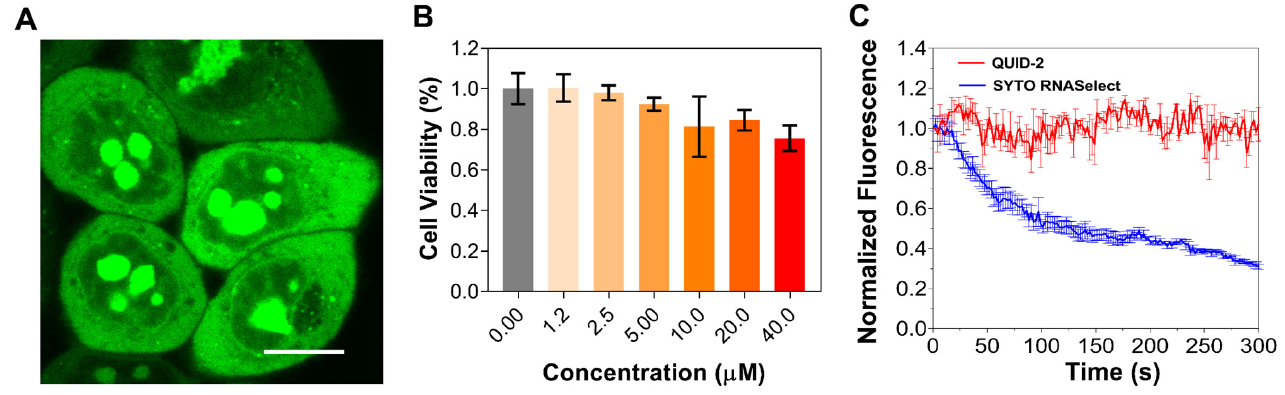
Figure 5. ( A ) Imaging of live HeLa cells stained with QUID − 2 (0.5 µ M, λ ex = 488 nm, λ em = 500–600 nm, green). ( B ) Viability of HeLa cells exposed to different concentrations of QUID − 2 for 48 h determined by MTT assay. ( C ) Quantitative analysis of the changes in fluorescence intensities of QUID − 2 and SYTO RNASelect in live cells under continuous excitation at 488 nm. Scale bars for cell image: 10 µ m.